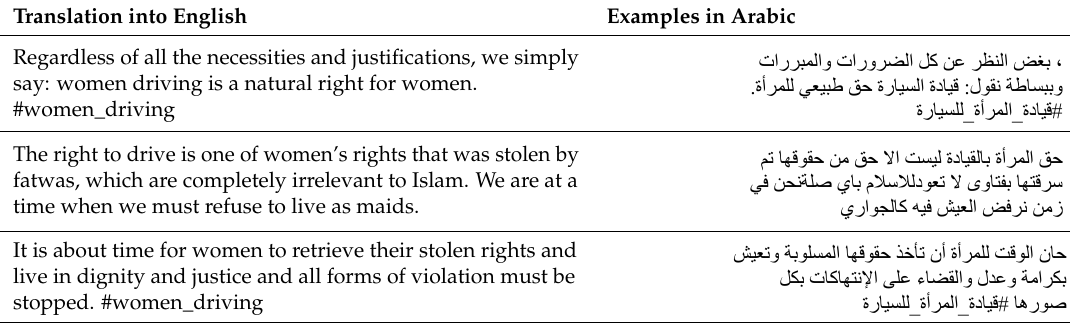
Table 4. Examples of normalizing women driving by affirming the state’s authority. Translation into English